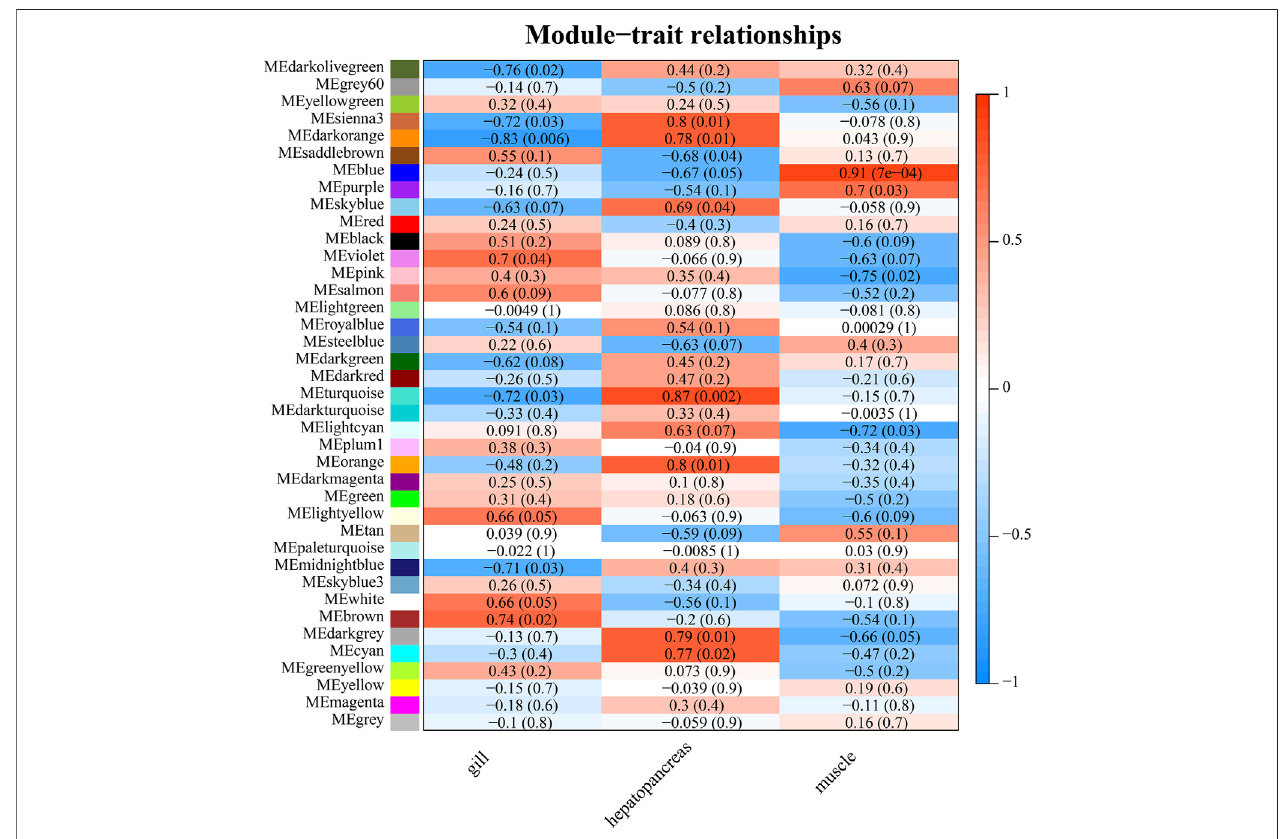
FIGURE 8 | Heat map of module-trait relationships. The p -value is indicated in parentheses. The correlation method is the person correlation coef fi cient. The value range is − 1 to 1. The larger the absolute value, the stronger the correlation. A value of less than 0 indicates a negative correlation.